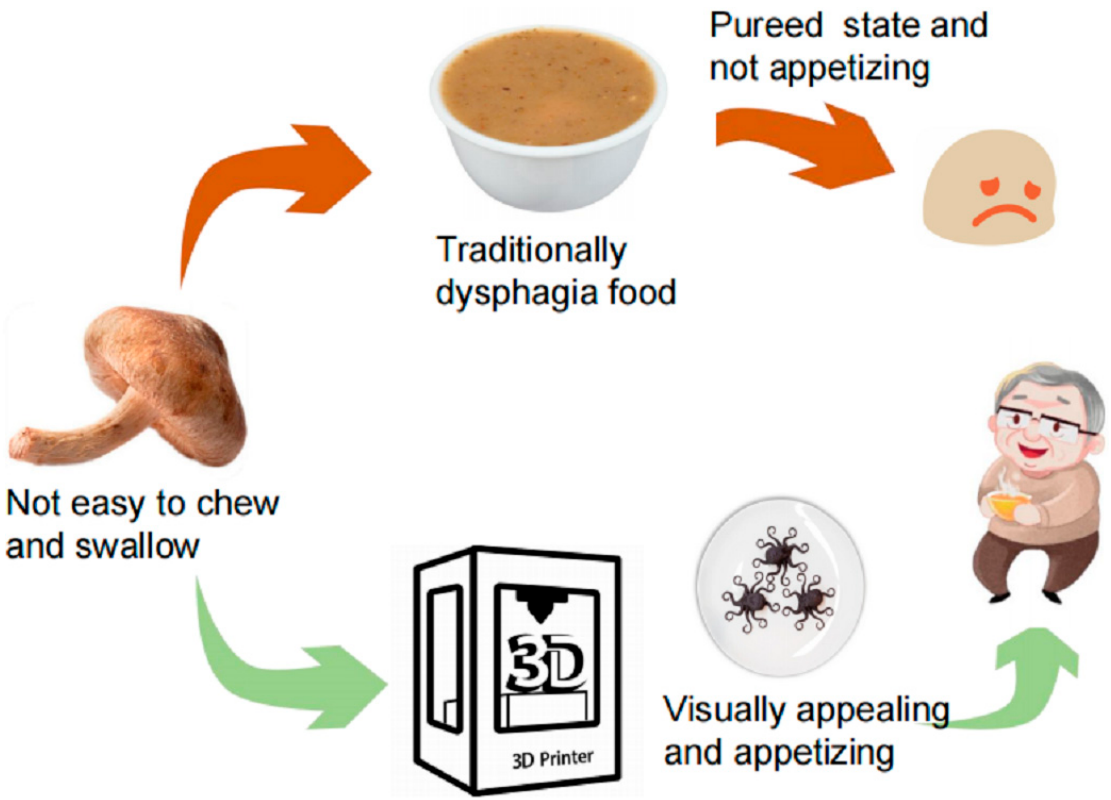
Figure 2. How 3D printing can help create more appealing dysphagia foods (Reprinted from Liu et al., 2021 [2]. Permitted by Creative Commons Attribution-Non Commercial 4.0 International License https://creativecommons.org/licenses/by/4.0/, accessed on 6 June 2022) [2].